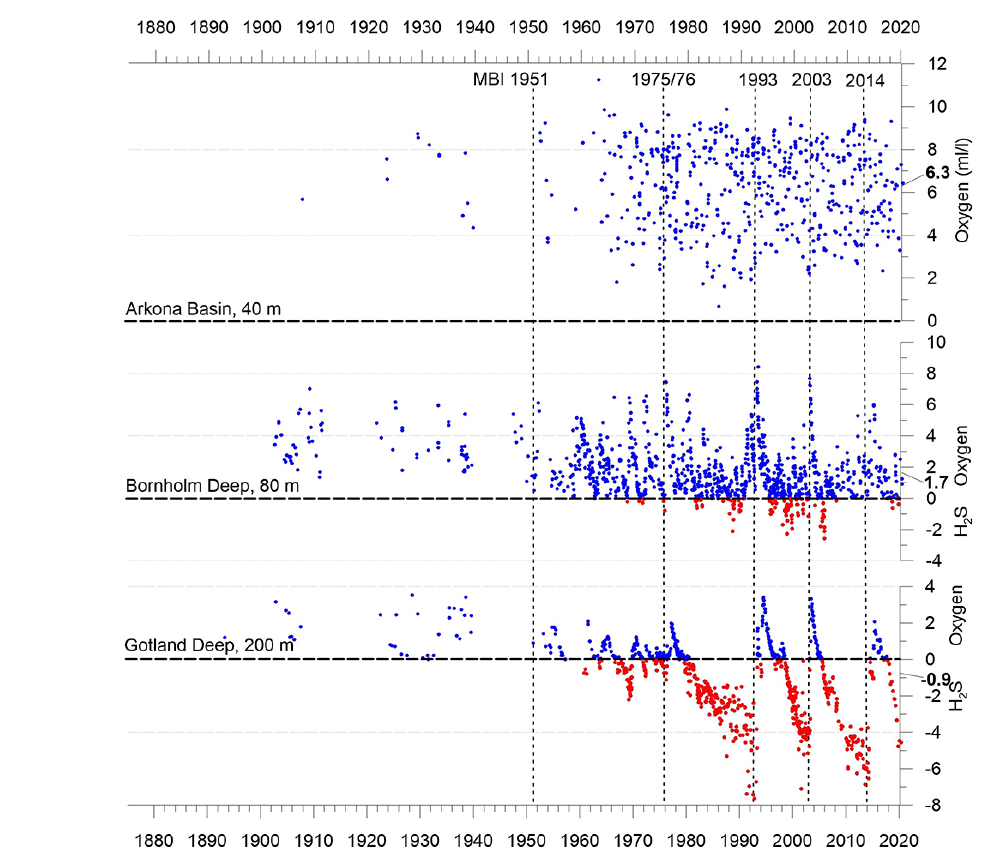
Figure 5. Long-term variations in dissolved oxygen concentrations (blue points) and hydrogen sulfide (red points, converted to negative oxygen equivalents) in the near-bottom layer at the key stations Arkona Basin (BY1, TF0113, 45m), Bornholm Deep (BY5, TF0213, 92m), and Gotland Deep (BY15, TF0271, 245m) (data sources: IOW-DB, https://odin2.io-warnemuende.de/, last access: 28 March 2022; ICES,